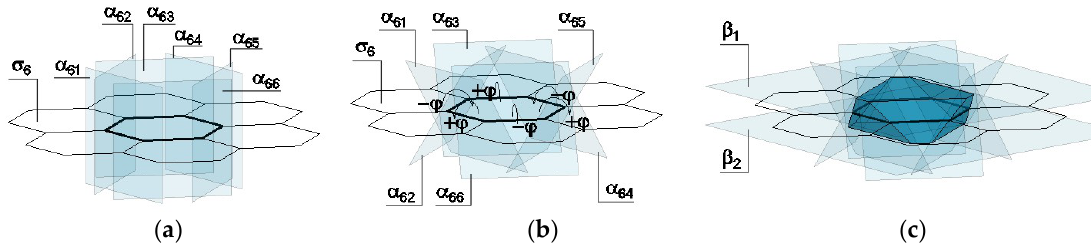
Figure 3. The procedure of modeling a vault component based on a regular hexagon: ( a ) establishment of a grid of hexagons σ 6 and insertion the planes α 6j perpendicular to it; ( b ) rotations of the planes α 6 j ; ( c ) final determination of a component shape with the use of planes β 1 and β 2 .